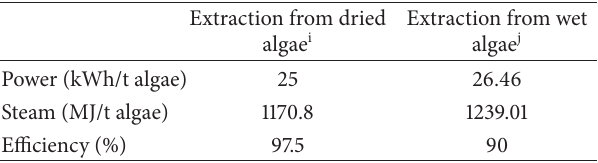
Table4:Energyconsumptionsandefficiencyforalgaloilextraction.